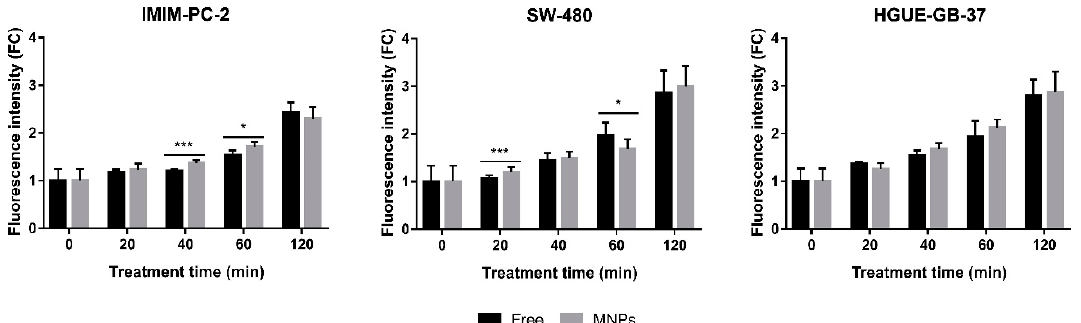
Figure 4. Intracellular reactive oxygen species (ROS) increase after CLytA-DAAO, free and bound to MNPs, and D-Ala treatment in IMIM-PC-2 pancreatic carcinoma cell line, SW-480 colorectal carcinoma cell line, and HGUE-GB-37 glioblastoma cell line. Cells were treated with 2 U/mL CLytA-DAAO and 1 mM D-Ala for 20–120 min. Free radical production was determined through DCFH 2 -DA probe and each treatment time had a control untreated that only contained the probe. Graph shows the fold change (FC) ± SD of fluorescent intensity with respect to the control ( n ≥ 6). * indicates a p -value < 0.05 and *** < 0.001.